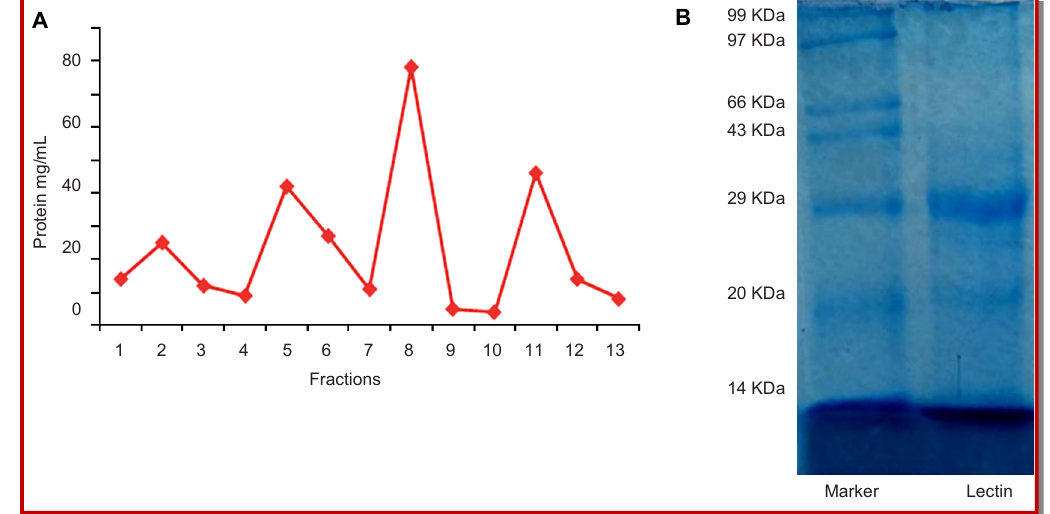
Figure 1: Elution profile of BanLec purification, with 80% ammonium sulfate precipitate on DEAE cellulose column (A); SDS- PAGE representing the molecular weight of BanLec (B). Left lane contained marker proteins and the right lane contained 10 µg of